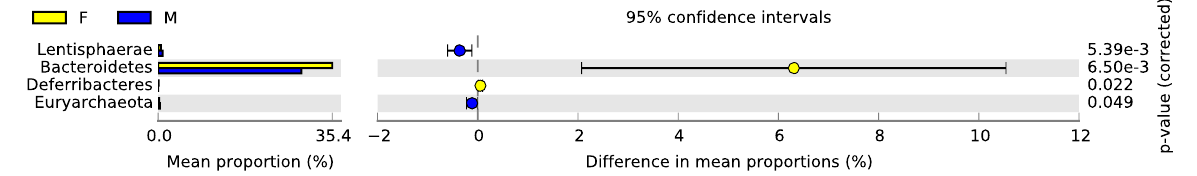
Figure 1. Extended error bar plot indicating the significant differences in mean abundance of phyla between males and females.